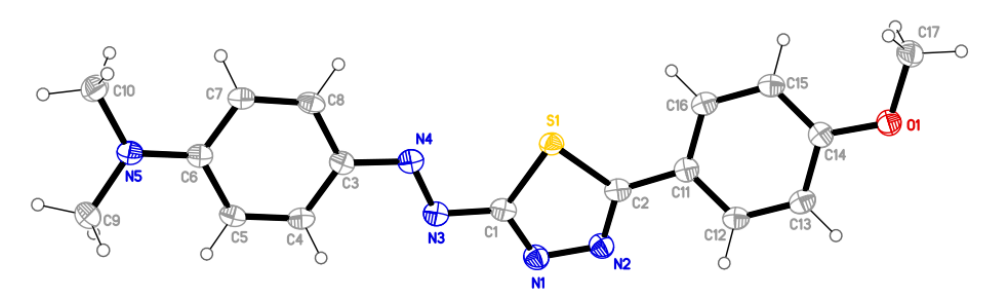
Figure 2. Molecular structure of compound 5b plotted with 50% probability of displacement ellipsoids. Hydrogen atoms are drawn as spheres with arbitrary radii.